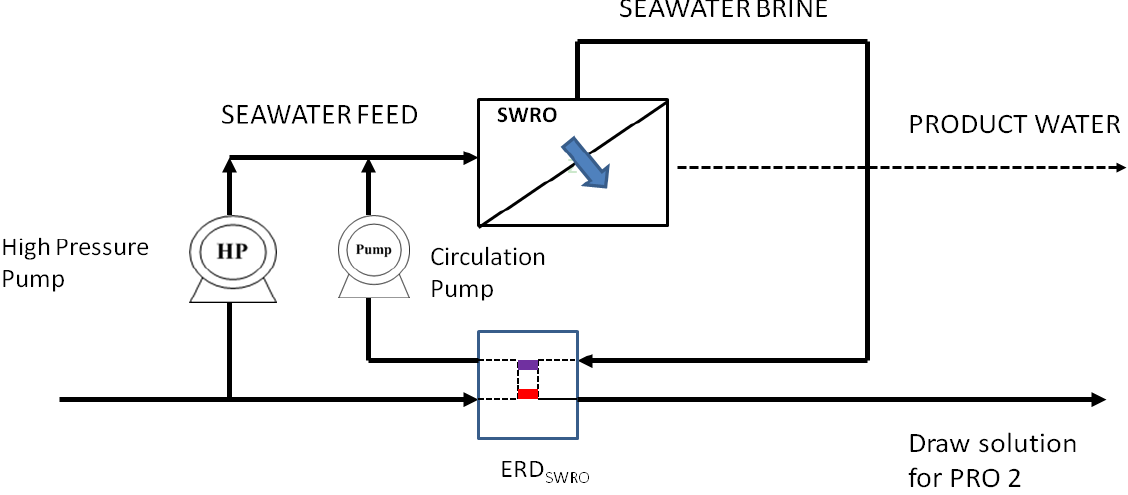
Figure 2. Seawater RO membranes (SWRO) process with isobaric energy recovery devices (ERD), ERD SWRO